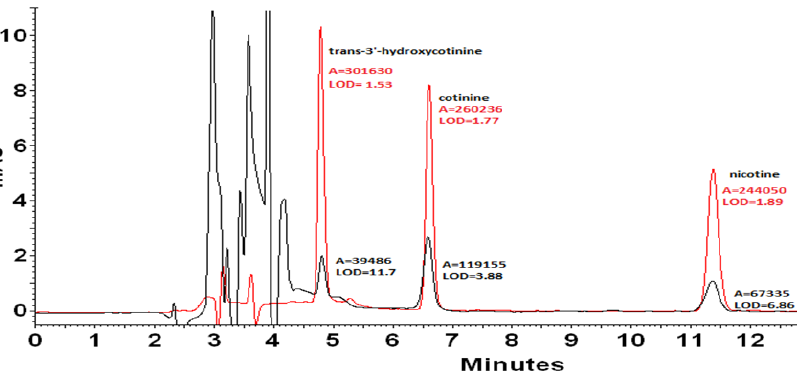
Figure 3. Chromatogram of a mixture of standards with a concentration of 2 mg mL − 1 dissolved in methanol (black line) and in the mobile phase (red line). The detection limits [ng mL − 1 ] were estimated considering the analyte concentration that produces a chromatographic peak having a height equal to three times the standard deviation of the baseline noise.